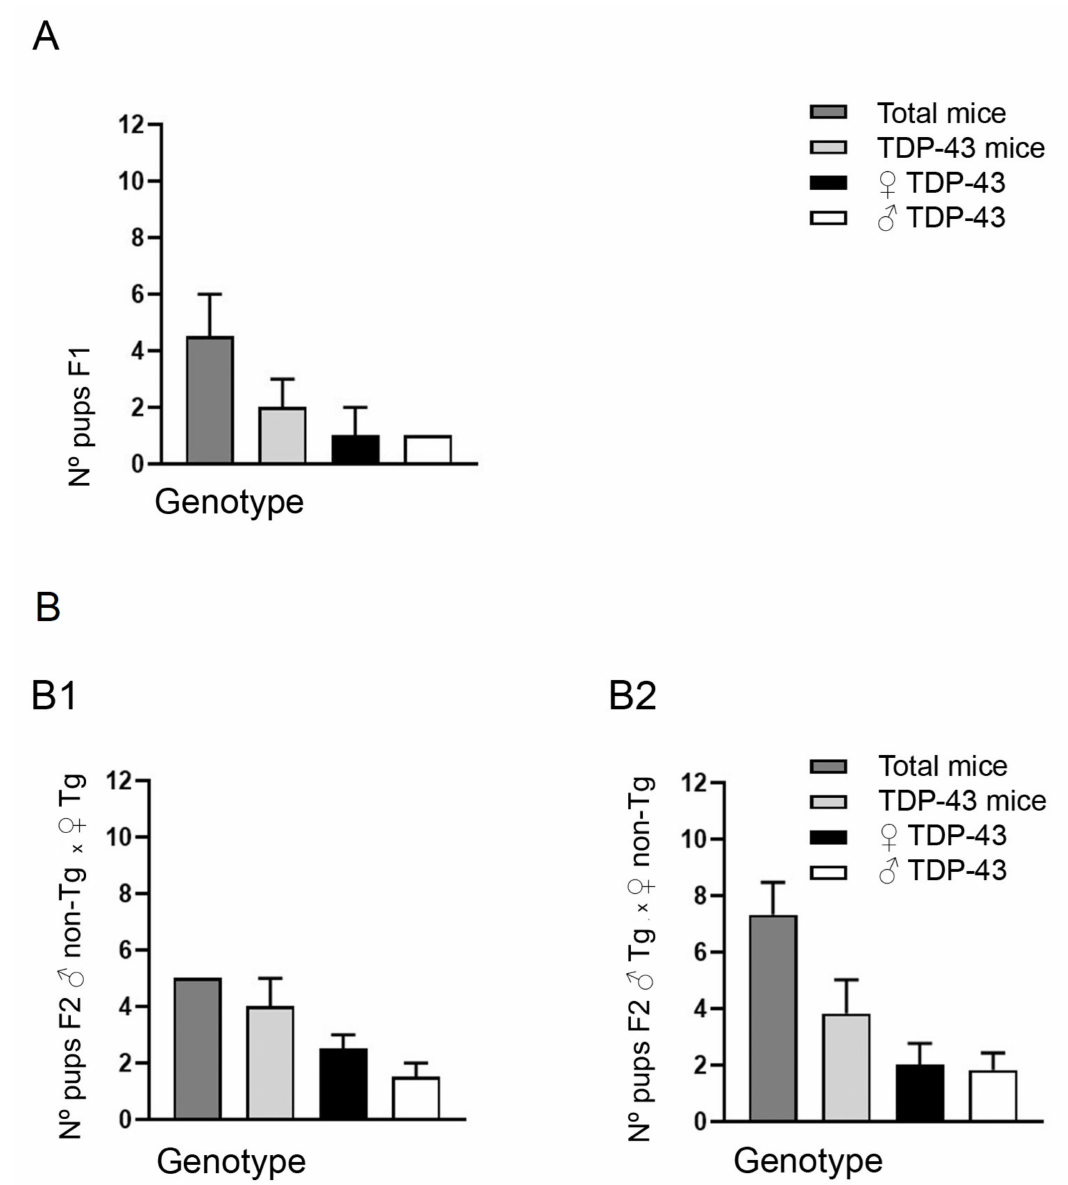
Figure 1. Analysis of prion protein (PrP) TAR DNA binding protein (TDP-43) A315T transmission across F1 and F2 generation. ( A ) F1 generation, data obtained from 2 crosses of TDP-43 A315T × C57BL6 / J. ♀ ♂ ( B ) F2 generation, data obtained from 2 crosses of C57BL6 / J × TDP-43 A315T ( B1 ) and F2 generation, ♀ ♂ data obtained from 6 crosses of TDP-43 A315T × C57BL6 / J ( B2 ). Y axis measures pups per litter mean ♀ ♂ and X axis represents the total number of mice (Total mice), Tg or TDP-43 A315T mice (TDP-43 mice), Tg female or TDP-43 A315T female mice ( TDP-43) and Tg male or TDP-43 A315T male mice ( TDP-43) ♀ ♂ on represented generation. Bar graphs represent the mean ± SEM. Abbreviations: Prp, prion protein; F1, first filial generation; F2, second filial generation; Tg, transgenic; SEM, standard error of the